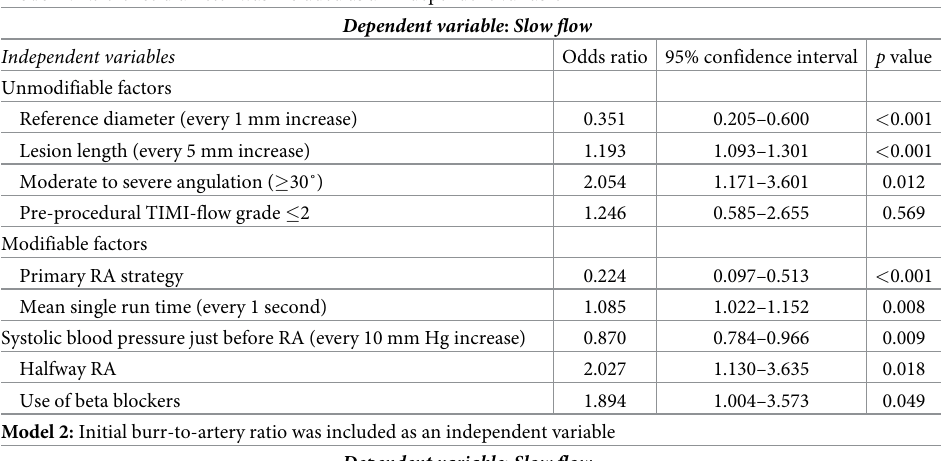
Table 5. Multivariate logistic regression model to find modifiable and unmodifiable factors associated with slow flow. Dependent variable: Slow flow ( � TIMI-2) just after RA Model 1: Reference diameter was included as an independent variable Dependent variable : Slow flow Independent variables Unmodifiable factors